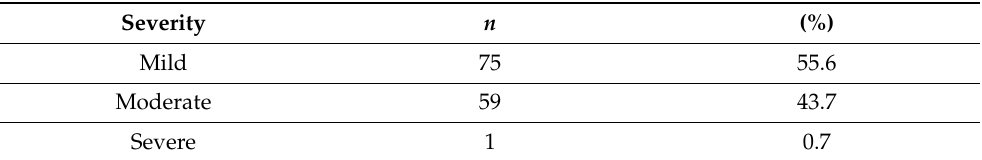
Table 9. Severity of adverse drug reactions among pediatric tuberculosis patients registered at Tashkent City Children Tuberculosis Hospital and Tashkent Regional Children Tuberculosis Hospital, Uzbekistan, 2019. Severity n (%) Mild 55.6 Moderate 43.7 Severe 0.7 ADR: Adverse drug